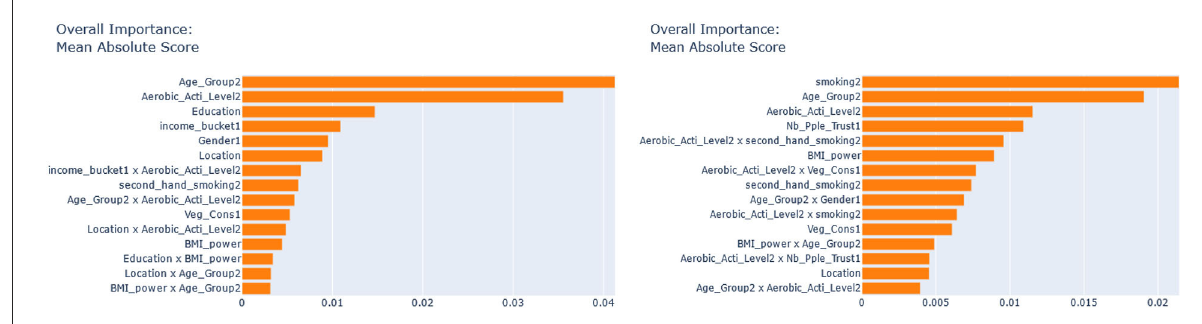
FIGURE4 EBM feature importance explaining the ln ˆ OR